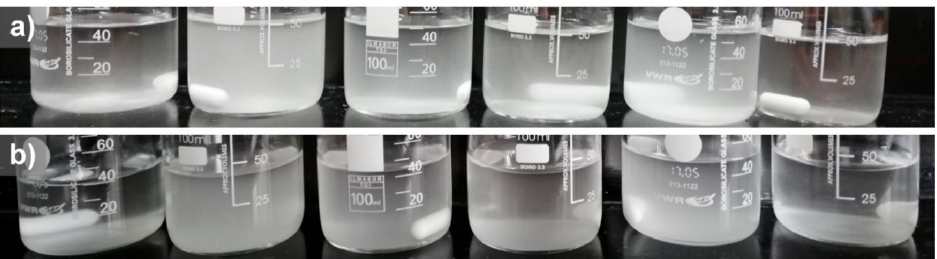
Figure 7. Solubility experiments of starch ( a ) directly after addition of starch and ( b ) after stirring for 24 h. From left to right: Native potato starch, native corn starch, native waxy corn starch, native wheat starch, oxidized potato starch, and oxidized corn starch.